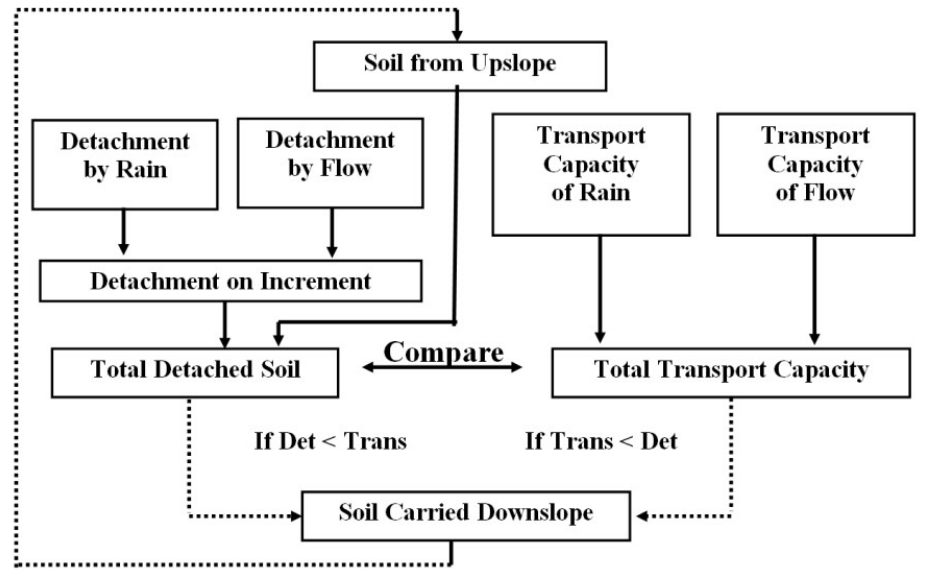
Figure 4. Approach used by Meyer and Wischmeier [50] to simulate the processes of soil erosion by water.